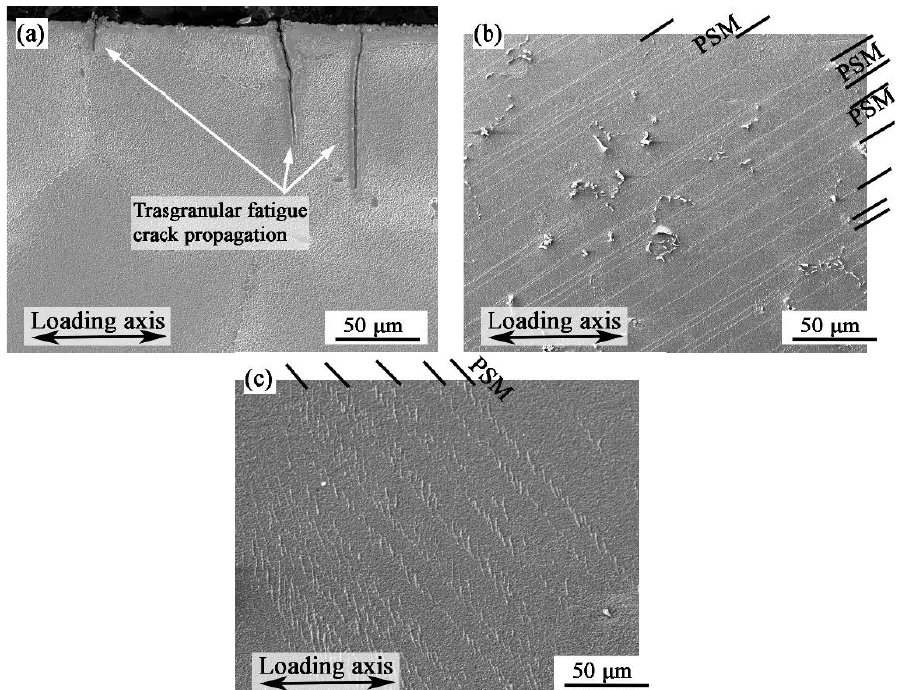
Figure 9. Typical TMF damage under OP loading ( a ) surface fatigue crack initiation and transgranular fatigue crack propagation ( b ) oxidized PSMs manifesting plastic strain localization into PSBs — temperature range 300 – 900 °C ( c ) wavy PSMs on the specimen surface tested in the temperature range 500 – 900 °C.